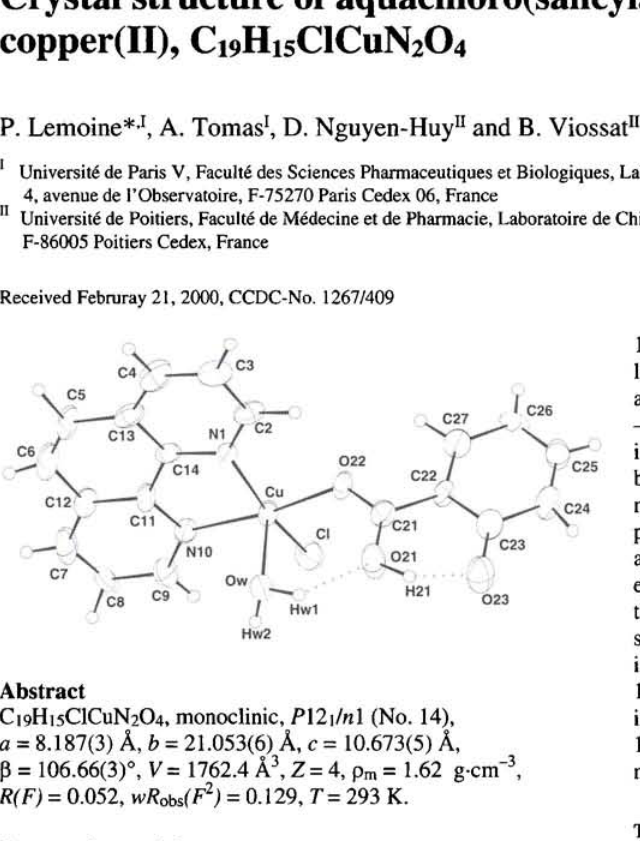
Table 1. Data collection and handling.